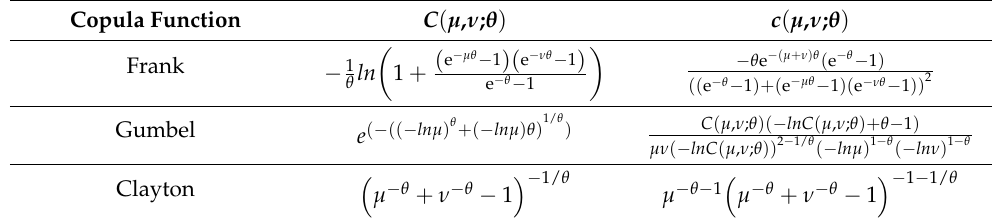
Table 1. The three different Copula functions. Copula Function C ( µ , ν ; θ ) c ( µ , ν ; θ )